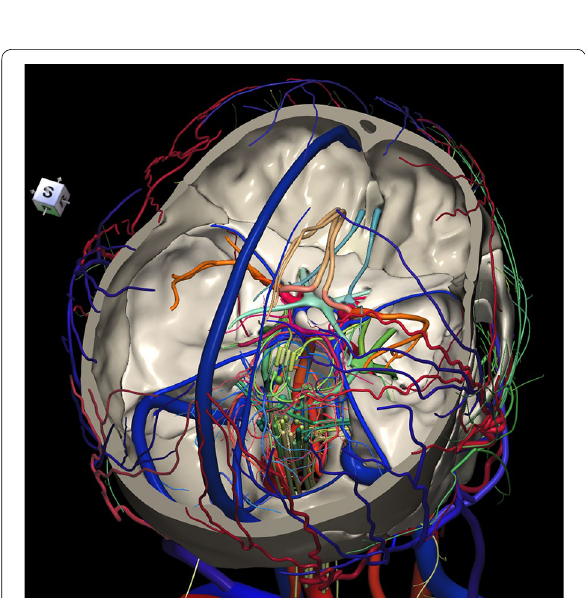
Fig. 6 Skull base with the cranial nerves, dural sinuses, extracranial vessels and selected intracranial arteries and